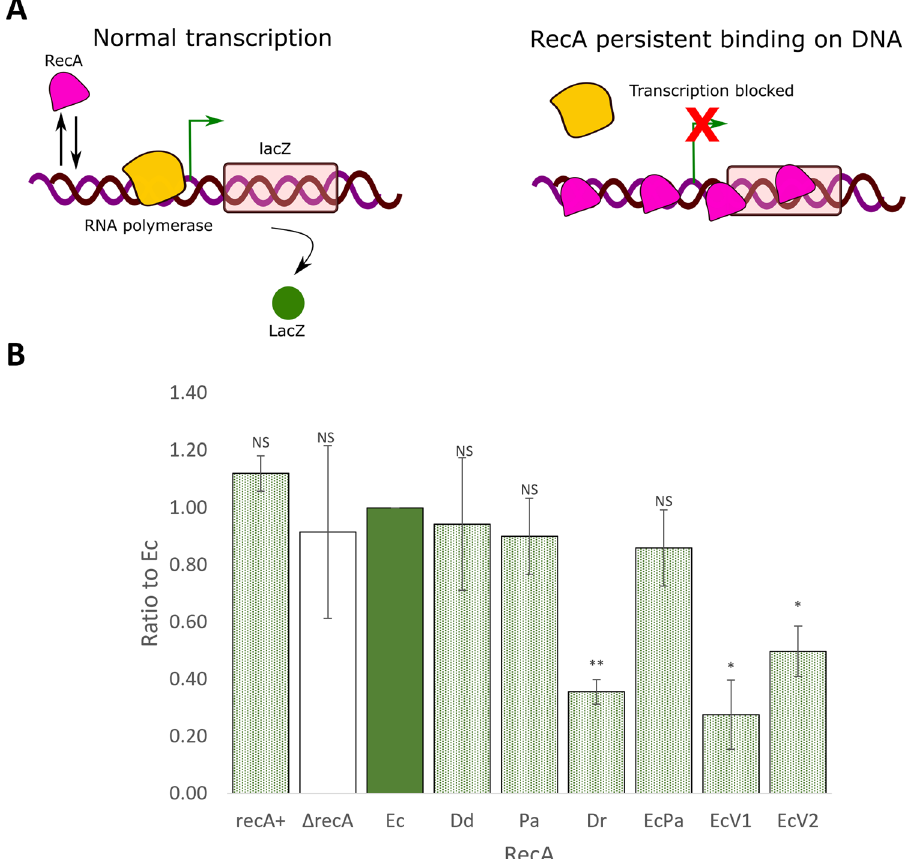
Figure 5. Effect of RecA variants on gene transcription. ( A) The scheme represents the effect of RecA persistently bound to DNA on transcription: when RecA binds to DNA and then dissociates, the transcription of lacZ gene is normal. When RecA is persistently bound to DNA, the transcription is blocked. ( B) Transcription was assessed by measuring the β-galactosidase activity of MG1655 recA ::Cm cells transformed with pQE-80L plasmid derivatives containing each of the seven recA variants and induced by 0.05 mM IPTG. The ratios of β-galactosidase activity in the presence of the variant versus β-galactosidase activity in the presence of EcRecA, used as a reference, were calculated for 3 different biological experiments. These ratios are represented as a histogram. The strains analysed are RecA + strain (green dot filled bar), ΔrecA strain (unfilled bar), ∆recA strain producing EcRecA (green filled bar, it is the reference but is presented for visual comprehension) and ∆recA strains producing the variants PaRecA, DrRecA, EcPa, EcRecAV1 and EcRecAV2 (green dot filled bars). NS indicated a non-significant p-value (from the one sample t test compared to 1, the EcRecA value), * indicates a significant p-value < 0.05 and ** a significant p-value < 0.005. Error-bars indicate